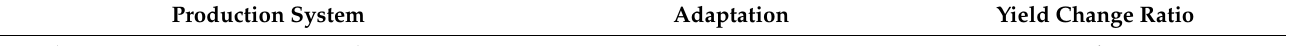
Table 3. Climate change analyses for the evaluation of potential changes in the agricultural system. Production